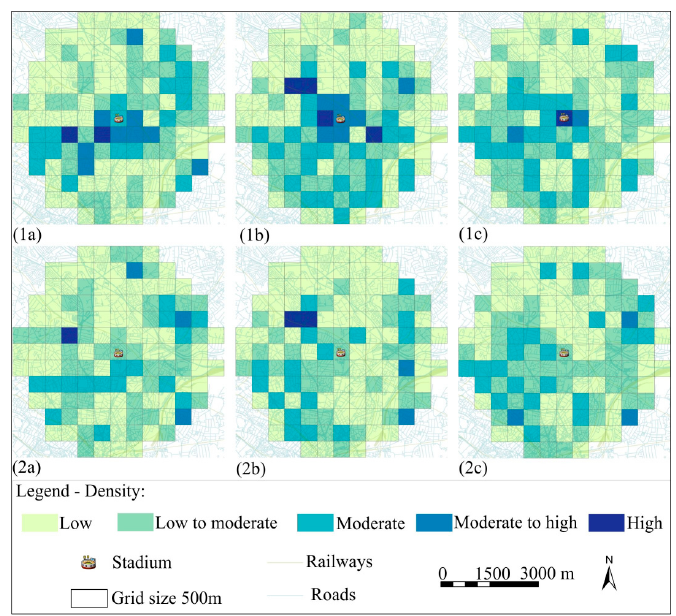
Figure 7. Density for each crime type ( a ) criminal damage, ( b ) theft and handling, and ( c ) violence against the person; ( 1 ) match days, ( 2 ) comparison days (using the Natural Jenks classification method).